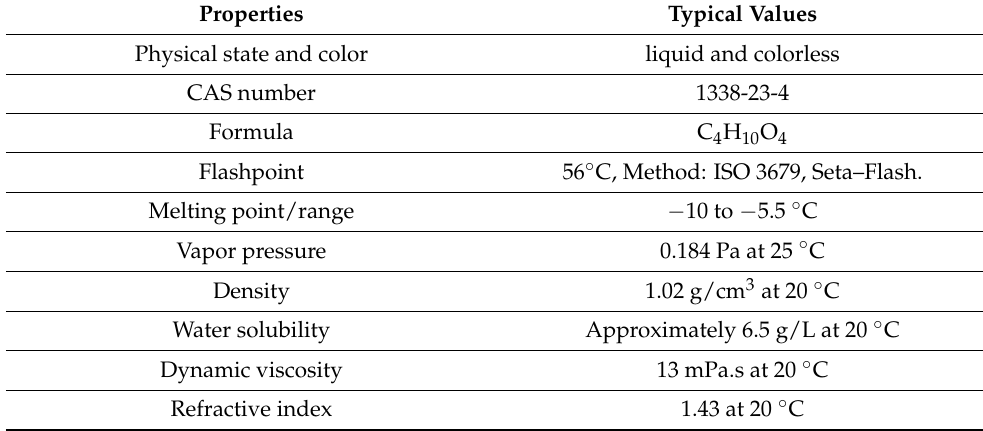
Table 2. Data of the Curox